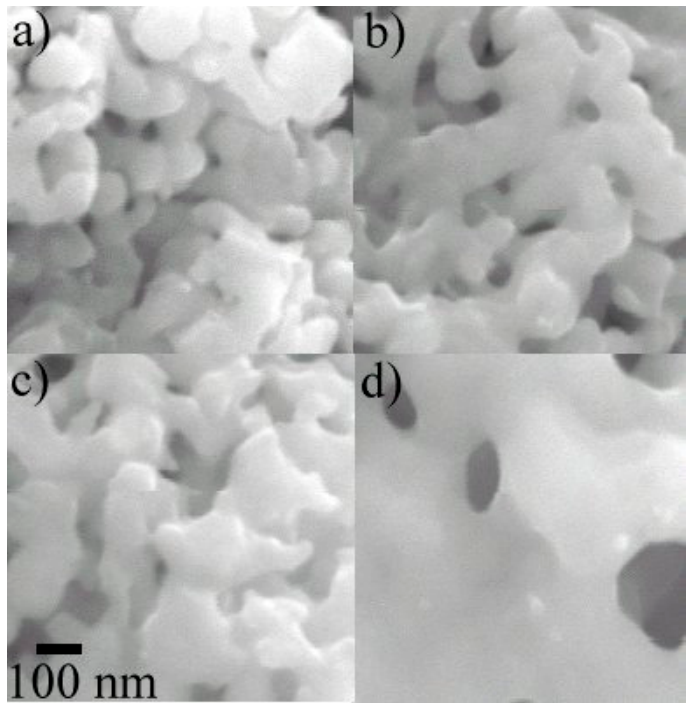
Figure 9. SEM micrographs showing the effect of reduction temperature on the microstructure of fluidizing powder; ( a ) 923 K, ( b ) 1023 K, ( c ) 1073 K, ( d ) 1173 K (at the same magnification) [9].